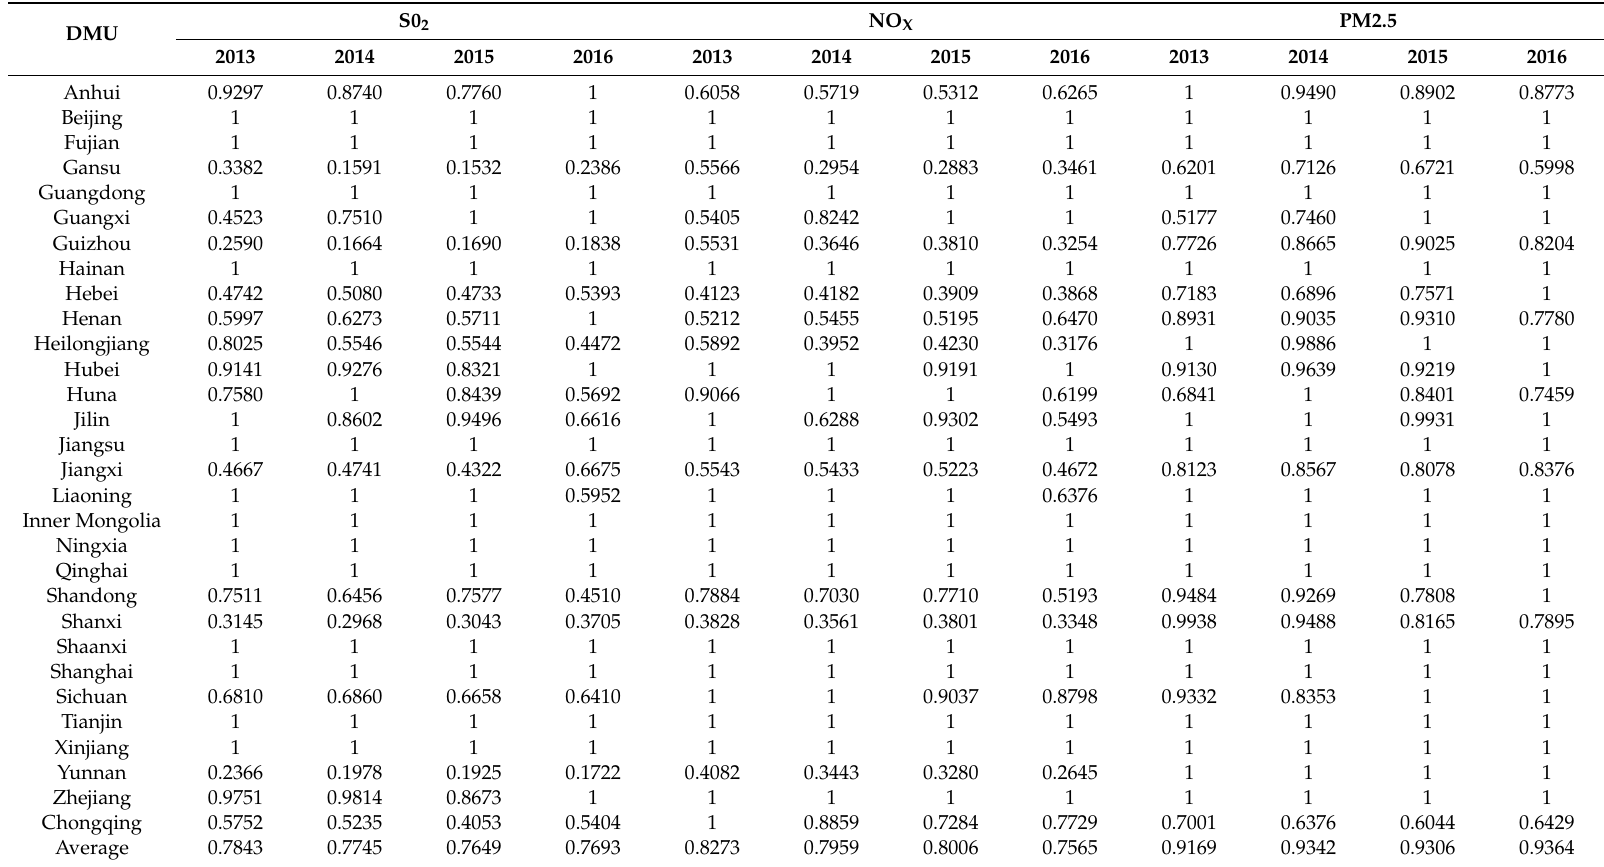
Table A2. Undesirable output e ffi ciency in